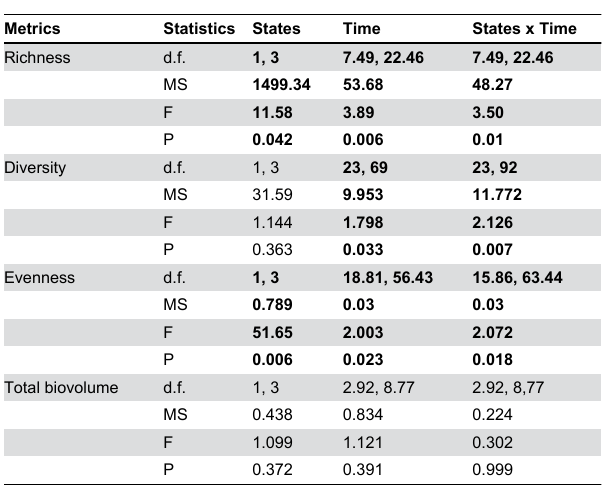
Table 1. Results of repeated measures ANOVA contrasting univariate community metrics (richness, diversity, evenness, total biovolume) between states (wet vs dry), time (24 months) and their interactions.